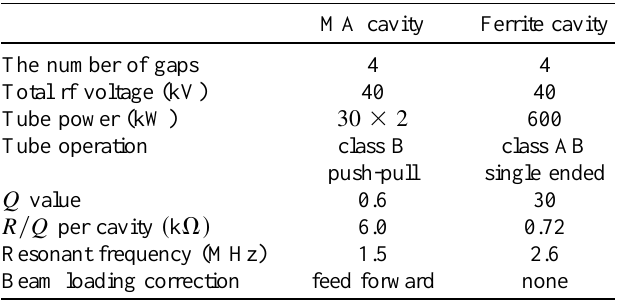
TABLE I. Barrier cavities